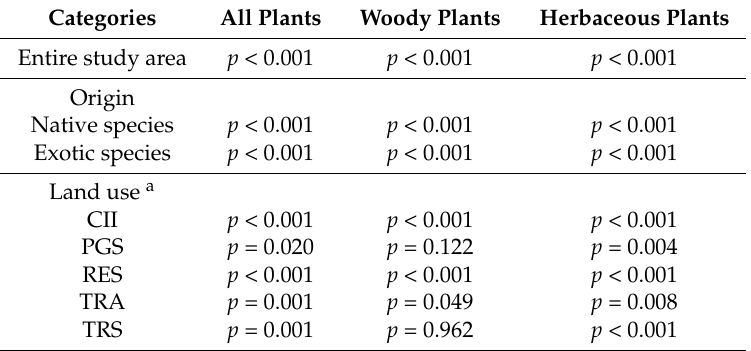
Table 3. Welch two sample t -tests on species richness between the built-up area (BUA) and the urban planning area (UPA) grouped by all plant species, native status, vegetation types, and land uses. Categories All Plants Woody